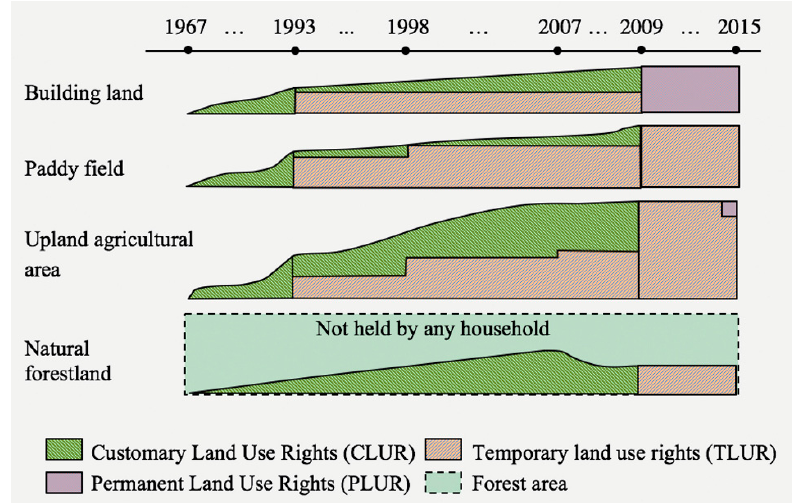
Figure 5. Changes of household land tenure level in the target village.